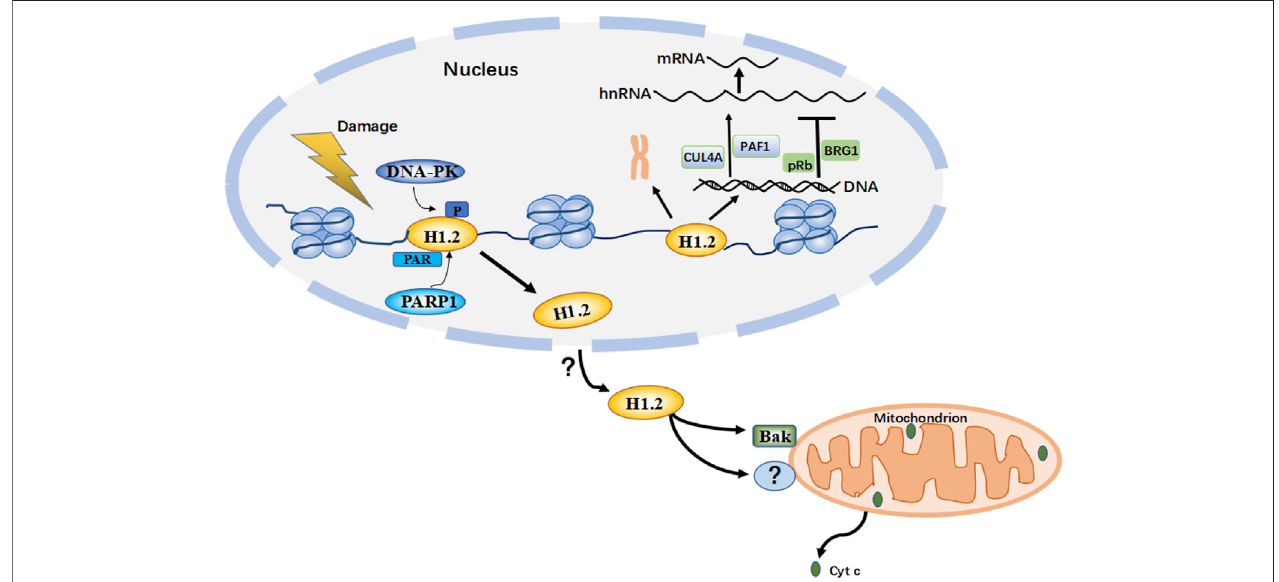
FIGURE 4 | This is a hypothetical model based on multiple studies of H1.2 PTM (post-translational modi fi cations) after DNA damage. When H1299 or U2OS cells are treated with DNA damage inducing agents etoposide or bleomycin, H1.2 is phosphorylated by DNA-PK (DNA-dependent protein kinase) in T146, these modi fi cations allow the recruitment of transcription factors to the target promoter regions of p53 and the remodeling of chromatin in response to DNA damage; treating HeLa, U2OS or other tumor cells with etoposide or ionizing radiation, but not UV irradiation, H1.2 is PARylated (Protein poly ADP-ribosylation) in S188 by PARP1 (Poly (ADP-Ribose) Polymerase 1) and displaced from chromatin for degradation, which is necessary to appropriately activate ATM (ataxia telangiectasia mutated) for regulatingtheresponsetoandrepairofDNAdamage;Thesemodi fi cationsalterthebindingaf fi nityofH1.2tochromatin,therebydissociatingH1.2fromchromatin.Upon DNA damageinducedbybleomycin or X-rayintumor cells such asMEFsand Hela, but notUVirradiation, via anunknown mechanism H1.2then undergoes nuclear-to- mitochondrial translocation and activates Bak (is a pro-apoptotic protein from the Bcl-2 protein family) or other unknown proteins to mediate apoptosis through the mitochondrial pathway. H1.2 also functions to compact chromatin and regulate transcriptional activity within the nucleus. (Cyc c: cytochrome